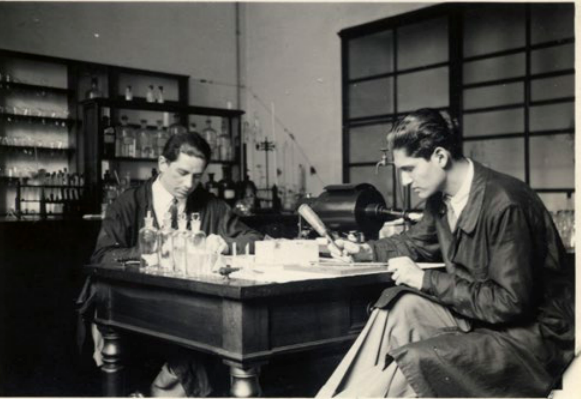
Figure 1. Zvi Enrico Jolles (left) with a colleague in a laboratory